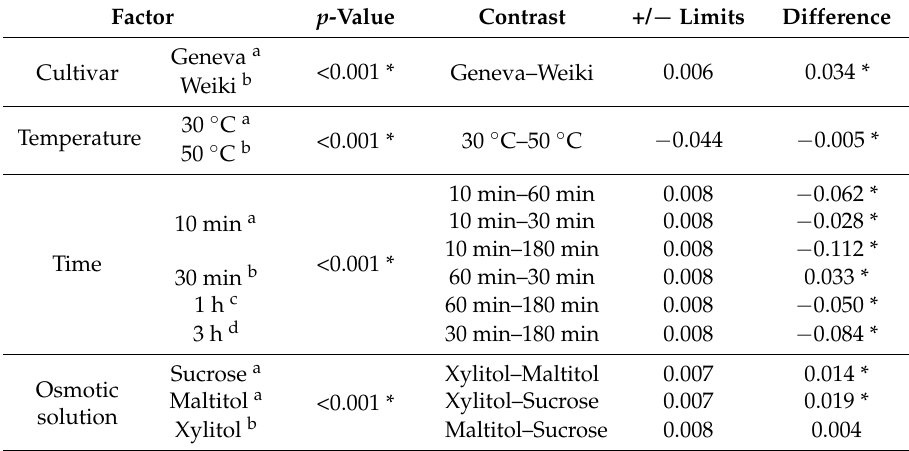
Table 1. The influence of osmotic pre-treatment in different solutions, and time on WR.